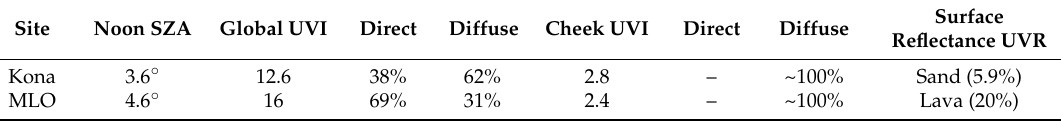
Surface Reflectance UVR